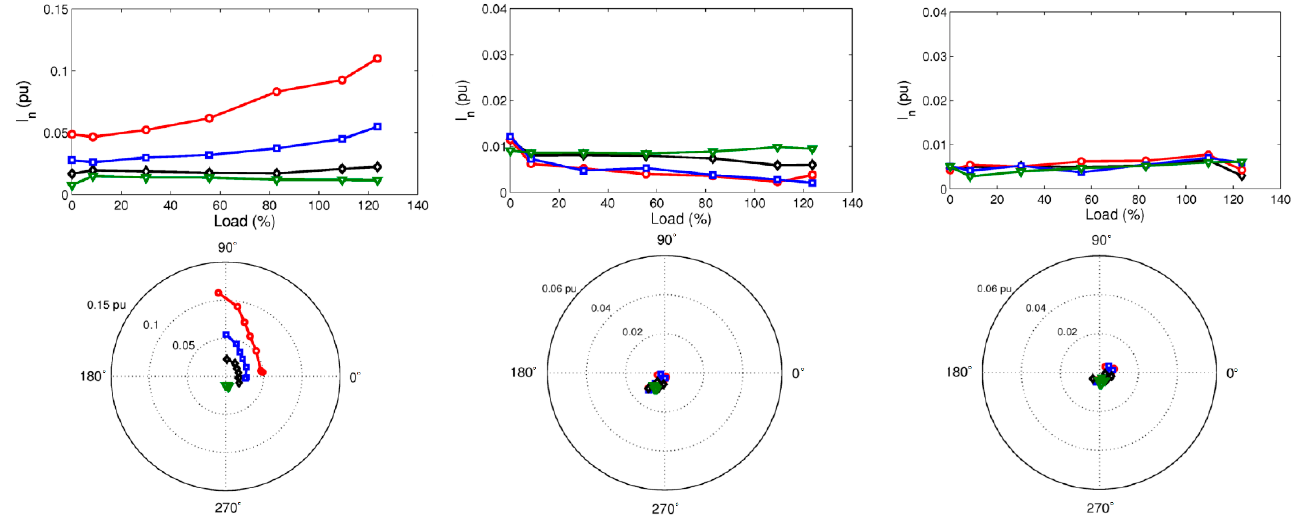
Figure 17. The test results (magnitude and phasor plots) of the negative sequence current at 1.7% shorted turn fault severity vs. motor load with various voltage unbalance factors: measured results ( left column ) after voltage unbalance compensation ( middle column ) and after voltage unbalance and inherent asymmetry compensation ( right column ).